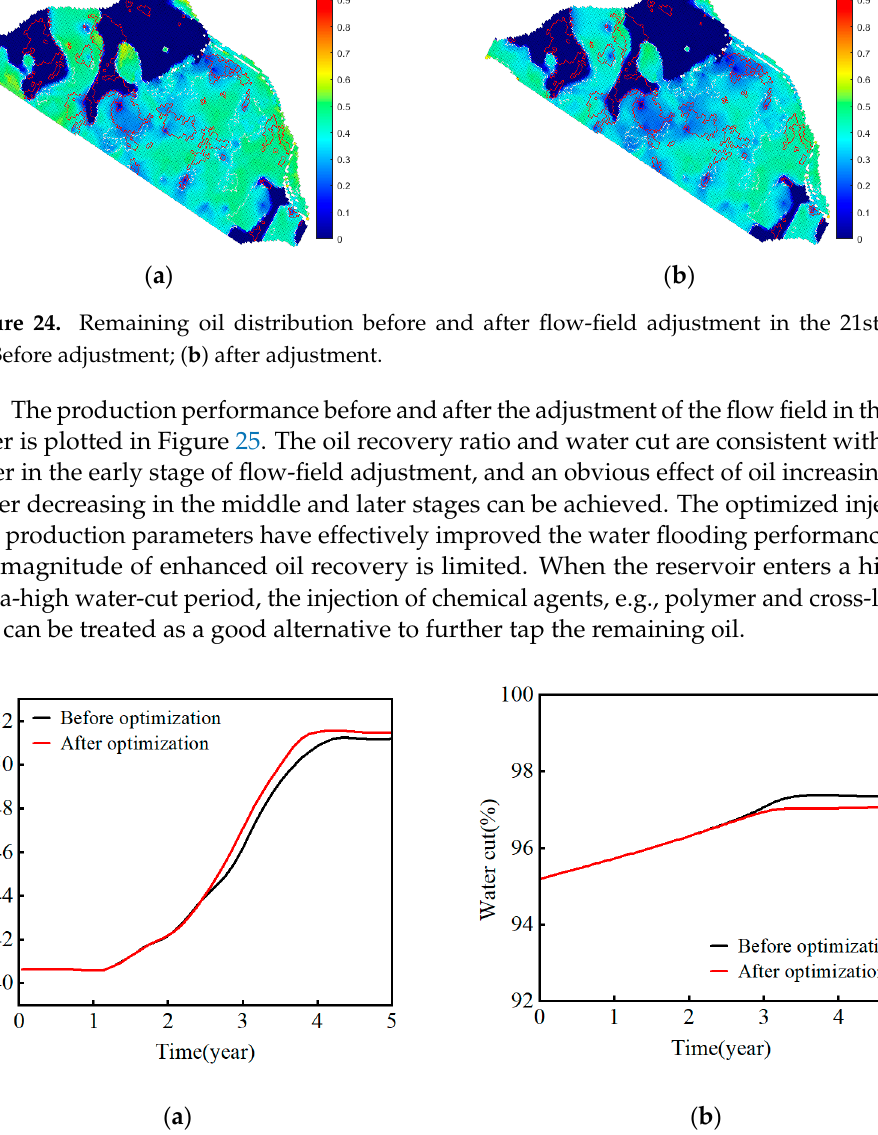
Figure 25. Oil recovery effect before and after flow-field adjustment in the 21st layer. ( a ) Oil recovery ratio; ( b ) water cut.